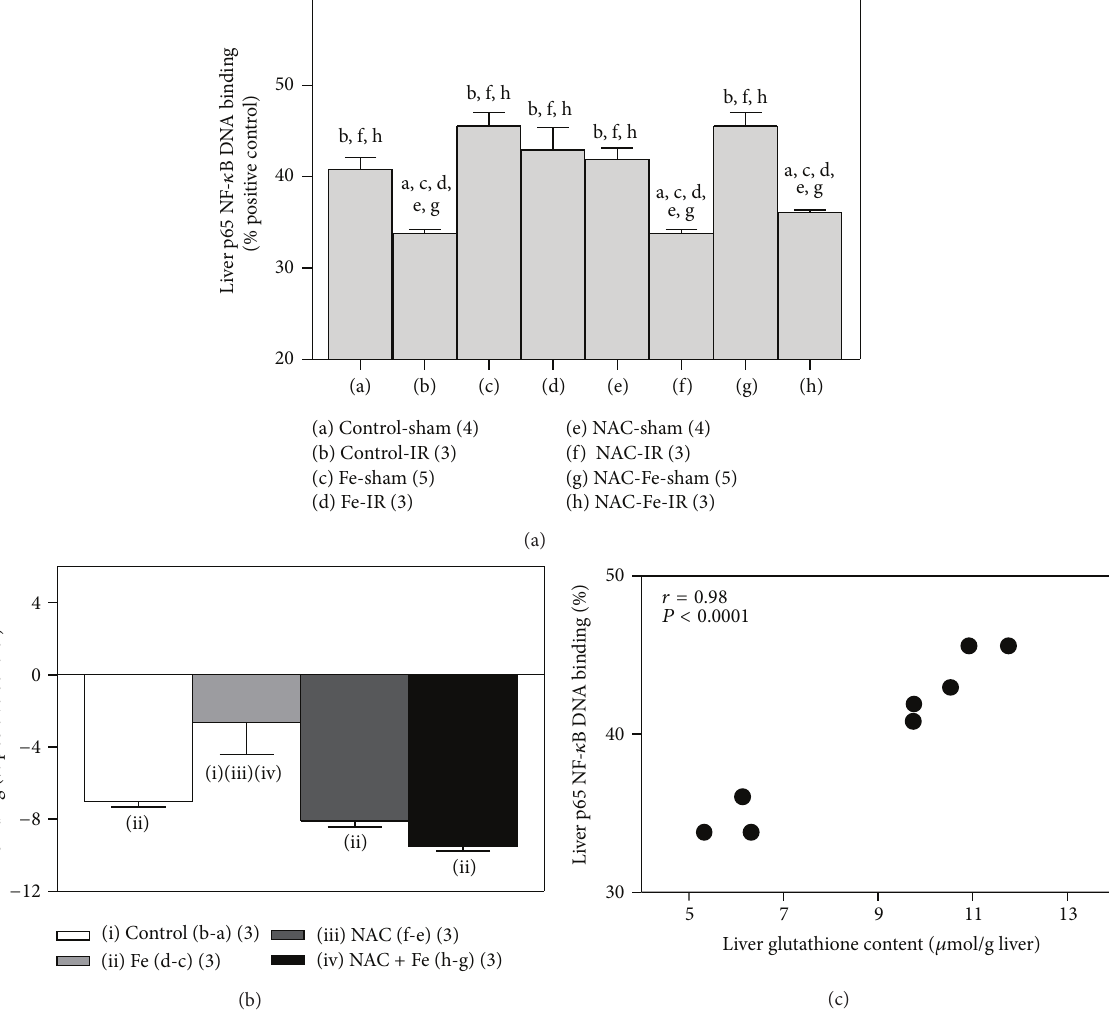
Figure 5: Effects of N-acetylcysteine (NAC) and/or iron (Fe) short-term administration on liver p65 nuclear factor- 𝜅 B (NF- 𝜅 B) DNA binding in rats subjected to ischemia-reperfusion (IR) (a), net changes in NF- 𝜅 B activation (b), and correlation between NF- 𝜅 B DNA binding and glutathione levels (c). Animals were treated as shown in Figure 1. Data are expressed as means ± SEM for 3 to 5 animals per group. Significance studies ( 𝑃 < 0.05 ; one-way ANOVA and the Newman-Keuls’ test) are indicated by the letters (a) or numbers (b) identifying each experimental group. In b, net changes in liver p65 NF- 𝜅 B DNA binding induced by IR correspond to the differences between groups (b-a) (controls), (d-c) (Fe), (f-e) (NAC), and (h-g) (NAC +